Question: Compose a caption that would accompany this figure in a paper.
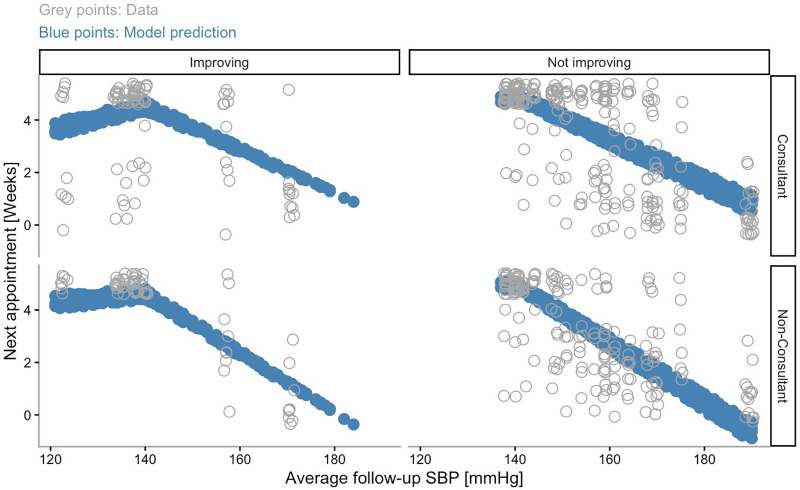
Answer: Agreement between elicited scheduling decisions (grey points, observed data) and model predictions (blue points), stratified by improvement trajectory (columns) and consultant status (rows). The x -axis is the average follow-up systolic BP and the y -axis is the chosen interval to the next appointment in weeks. Predicted values can fall slightly below zero where the model extrapolates beyond the “see immediately” option; these are read as a request for review at the earliest opportunity.